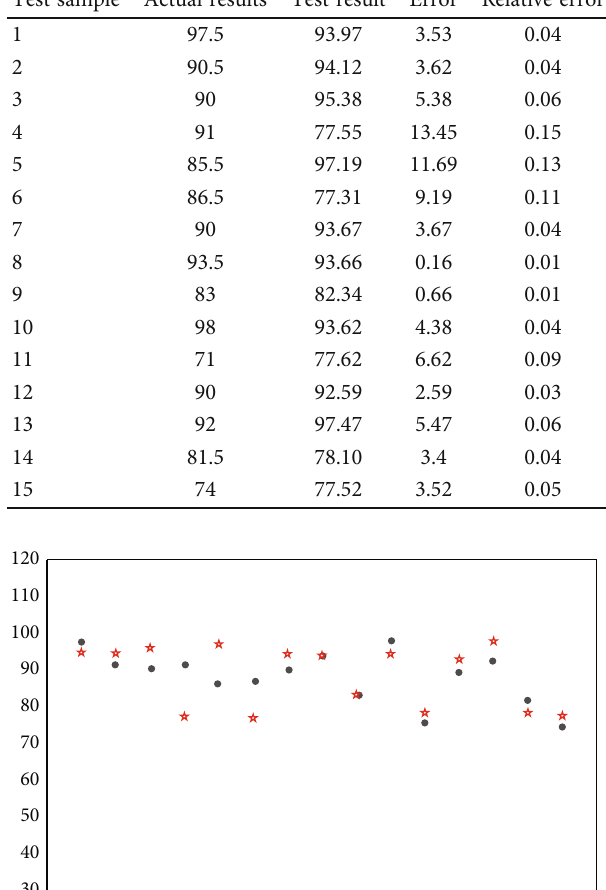
Table 1: Comparison of actual evaluation results and BP simulation evaluation results.